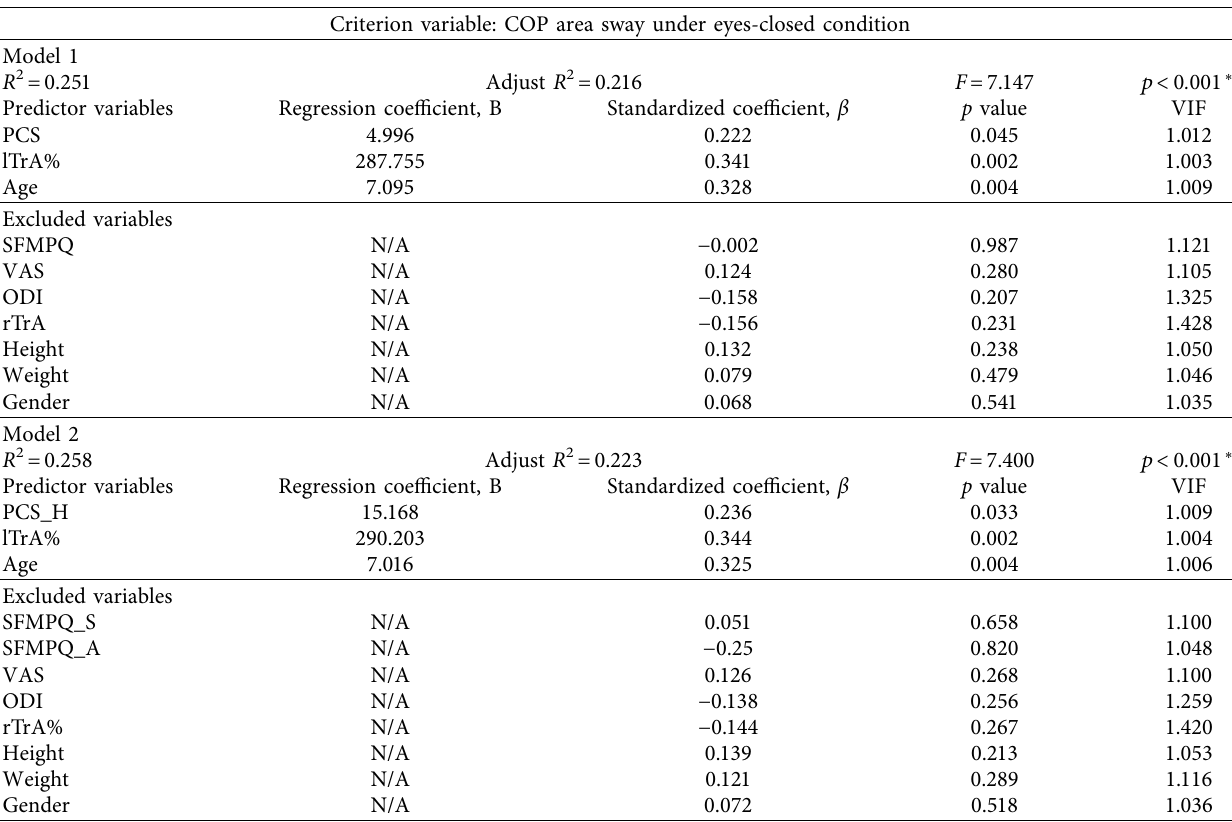
Table 4: Multiple linear regression for clinical measures and pain